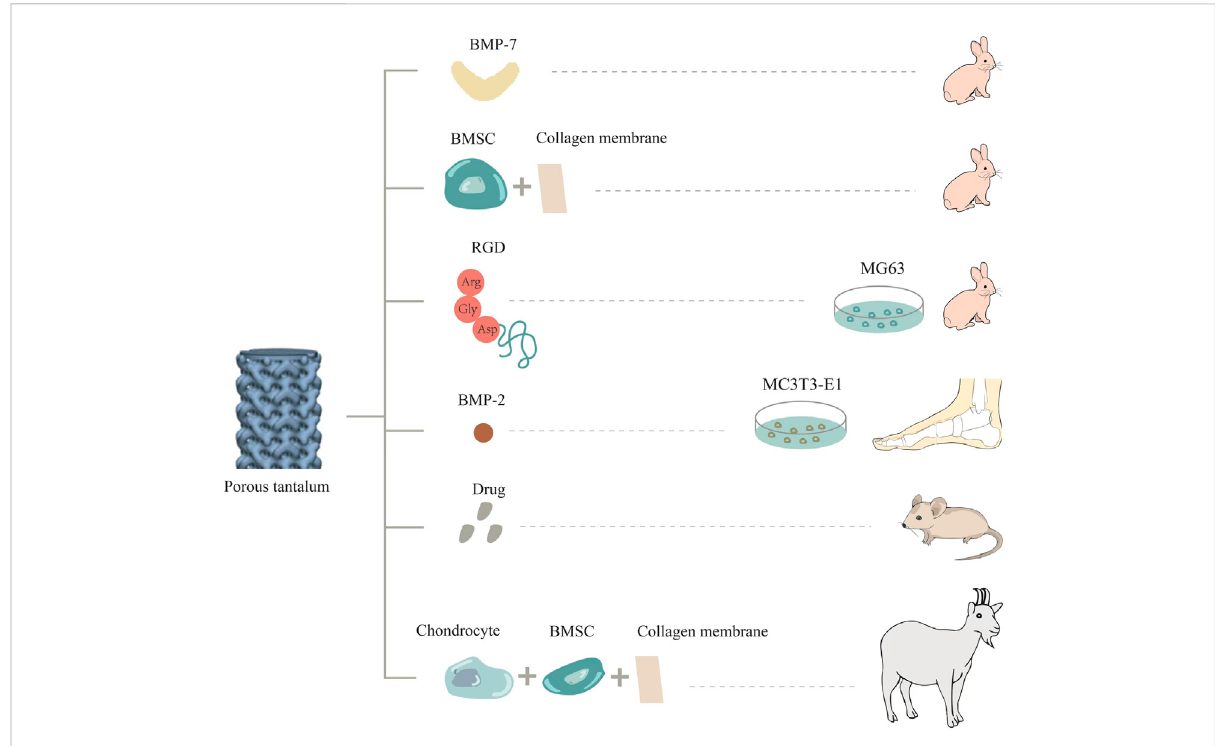
FIGURE 2 Surface functionalization involving bioactive ingredients of porous